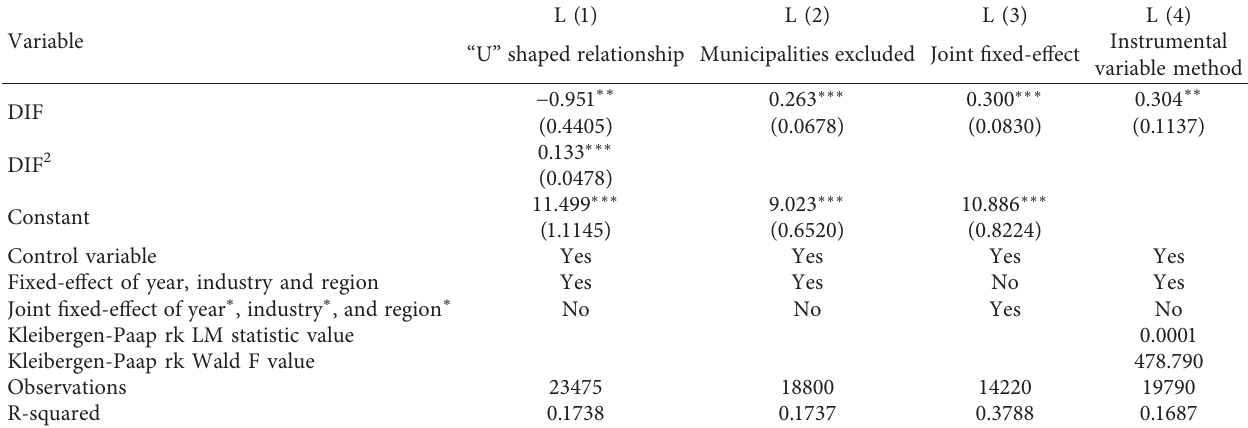
Table 7: Robustness test.